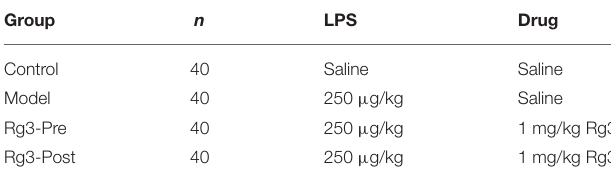
TABLE 2 | Experimental design (experiment 2).